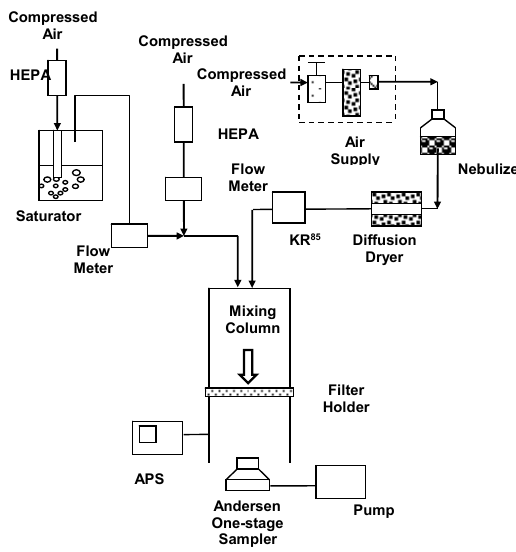
Figure 1. Schematic diagram of the experimental system.